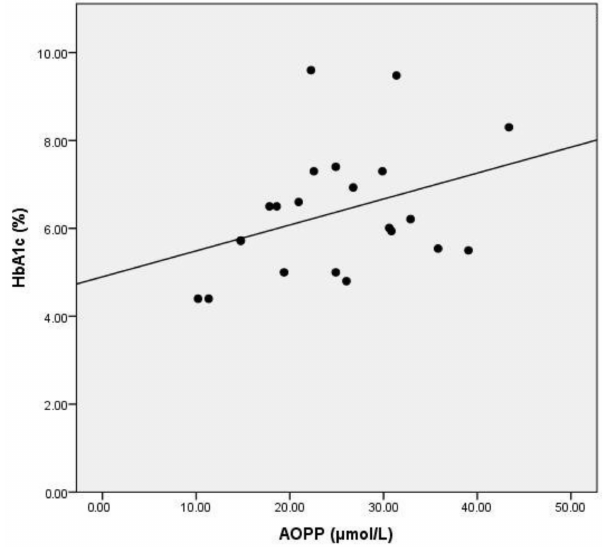
Figure 4. Correlation between AOPP and glycated hemoglobin values. Legend: AOPP = advanced oxidation protein products.